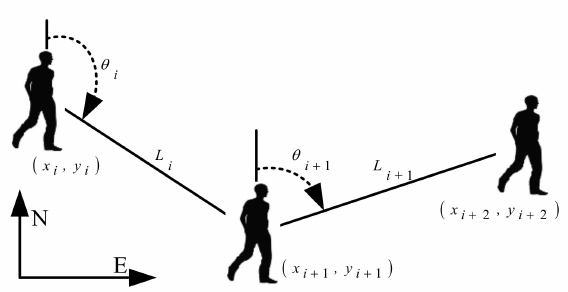
Figure 1. Schematic of pedestrian dead reckoning (PDR).